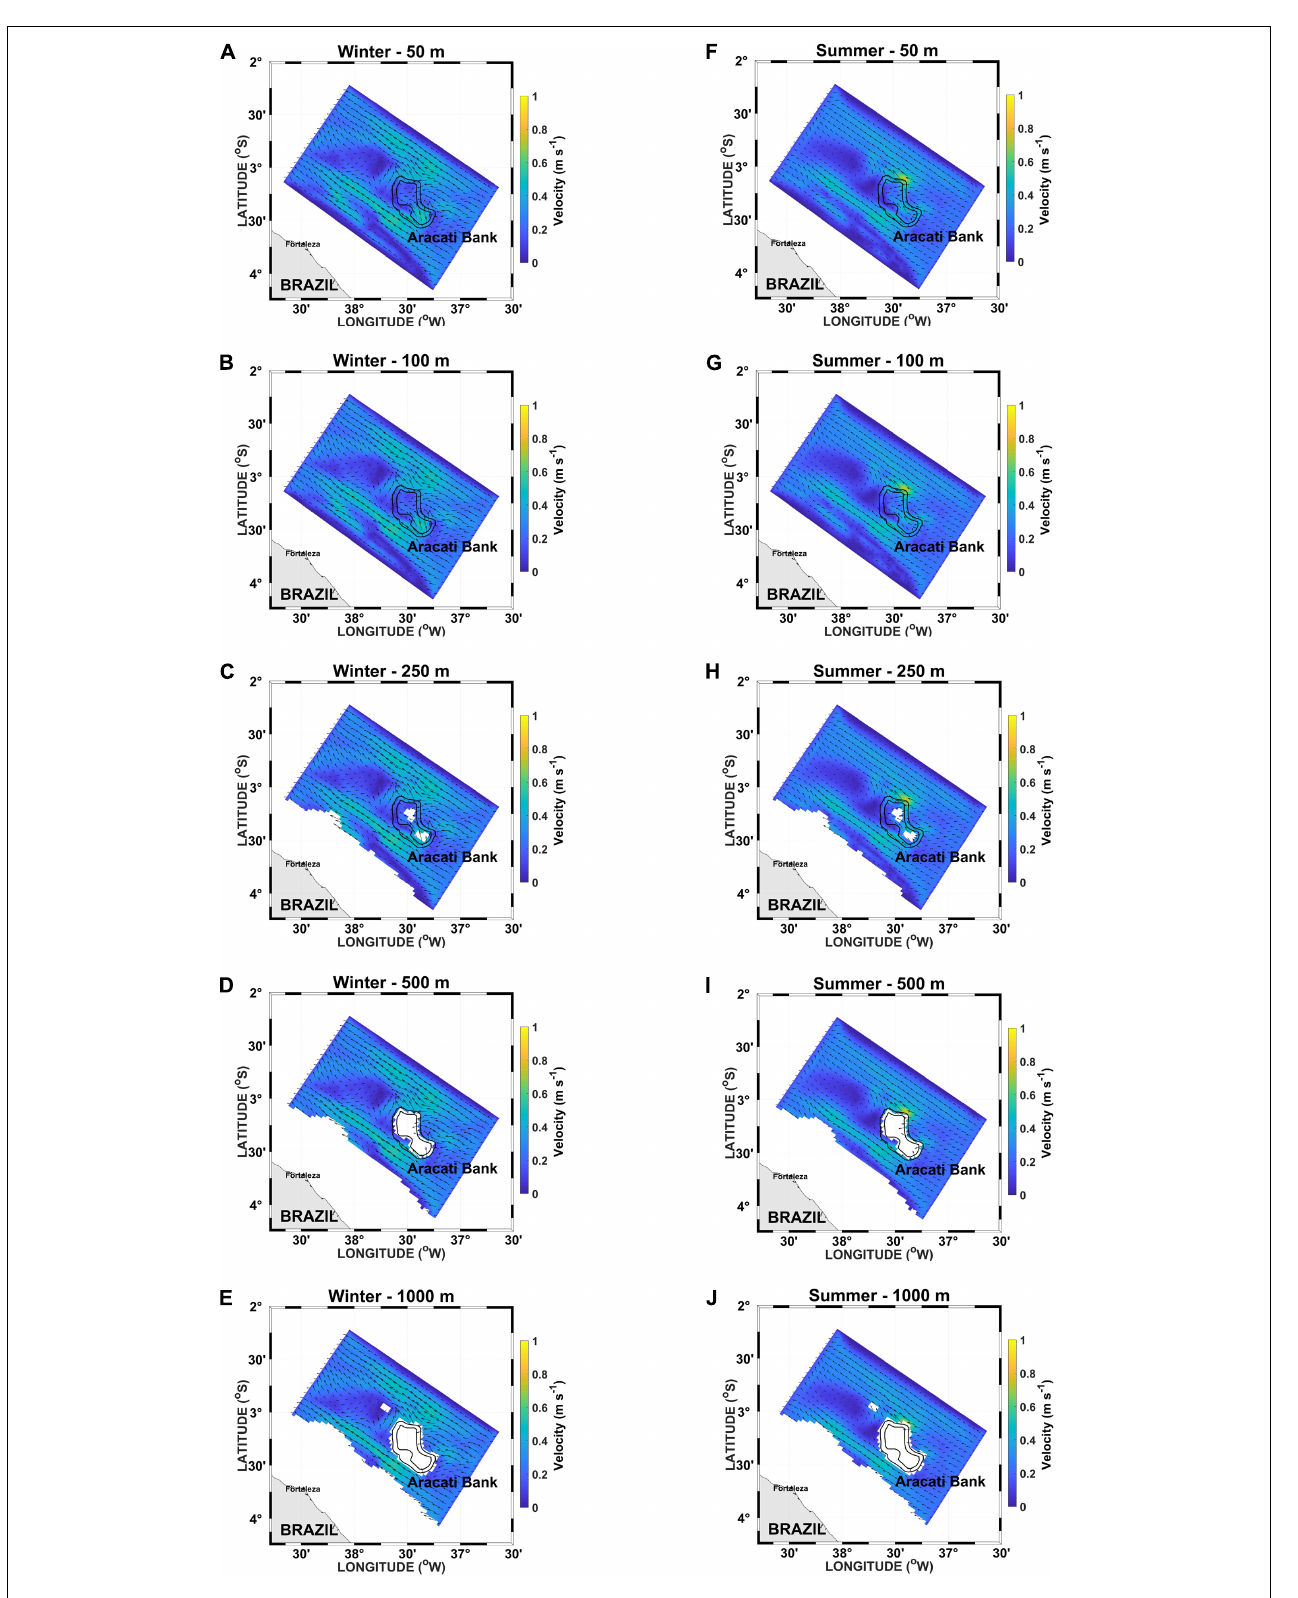
FIGURE 7 | Horizontal velocity (m.s - 1 ) fields in the Aracati Bank area at depths of 50, 100, 250, 500, and 1,000 m during winter (A–E) and summer (F–J) seasons.